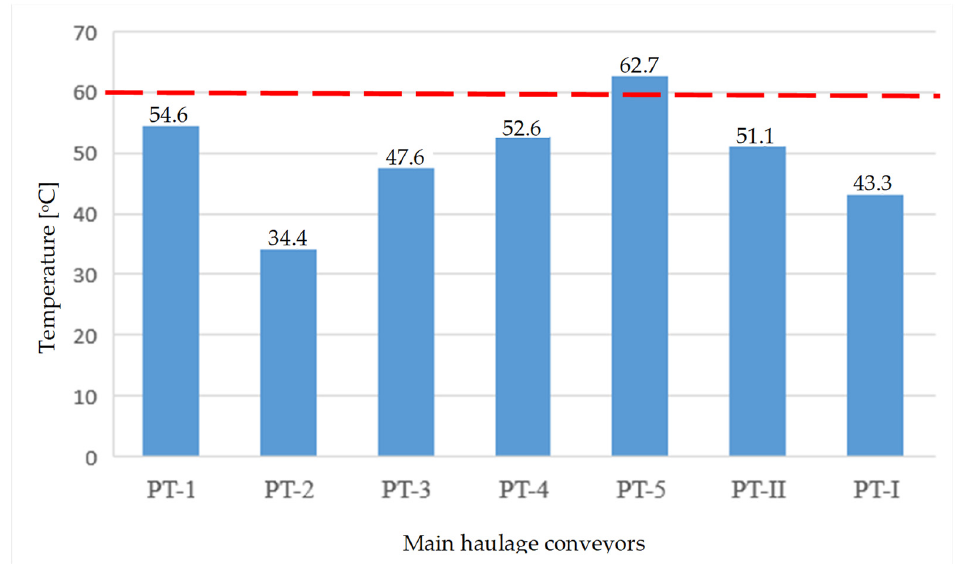
Figure 10. Summary of test results obtained for the drive units.